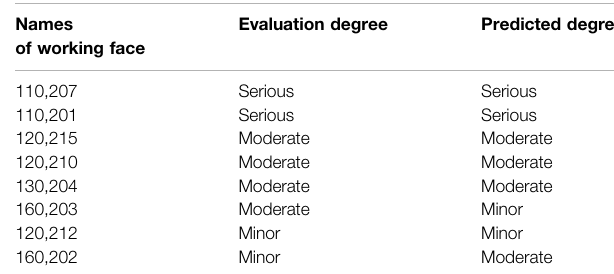
TABLE 6 | Comparison of the degree of surface